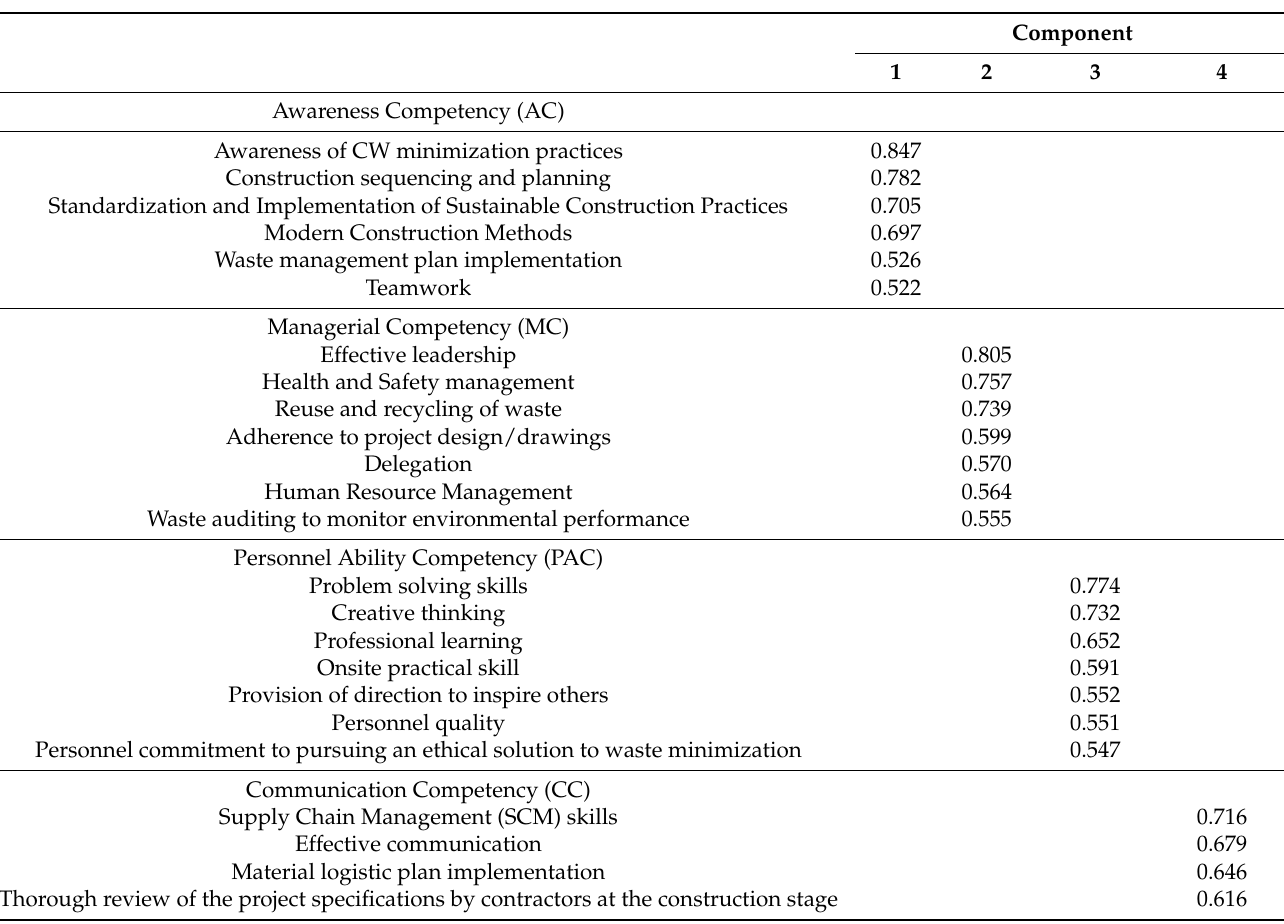
Table 5. Rotated Component Matrix on Competencies that Drive Material Waste Minimization at the Construction Stage of